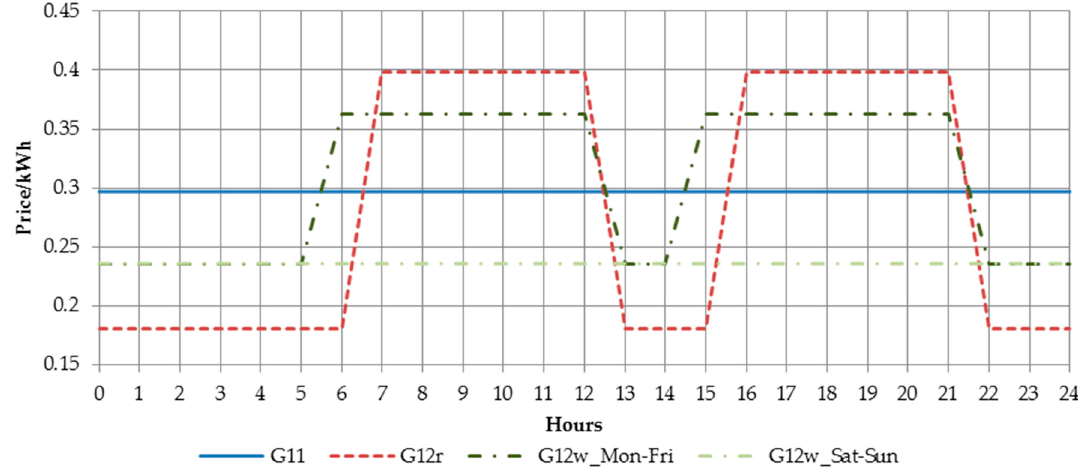
Figure 5. Prices in G11, G12r and G12w tariff plans (1 Polish PLN~0.25 EUR).